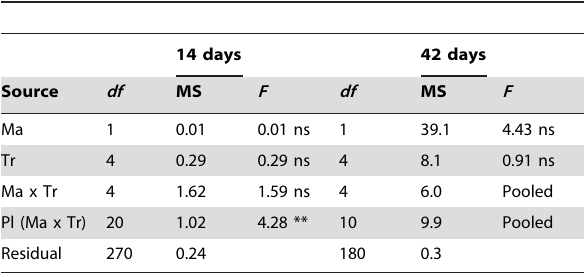
Table 5. Analyses of mean densities of chlorophyll- a for each treatment 14 or 42 days after the start of the experiment.*